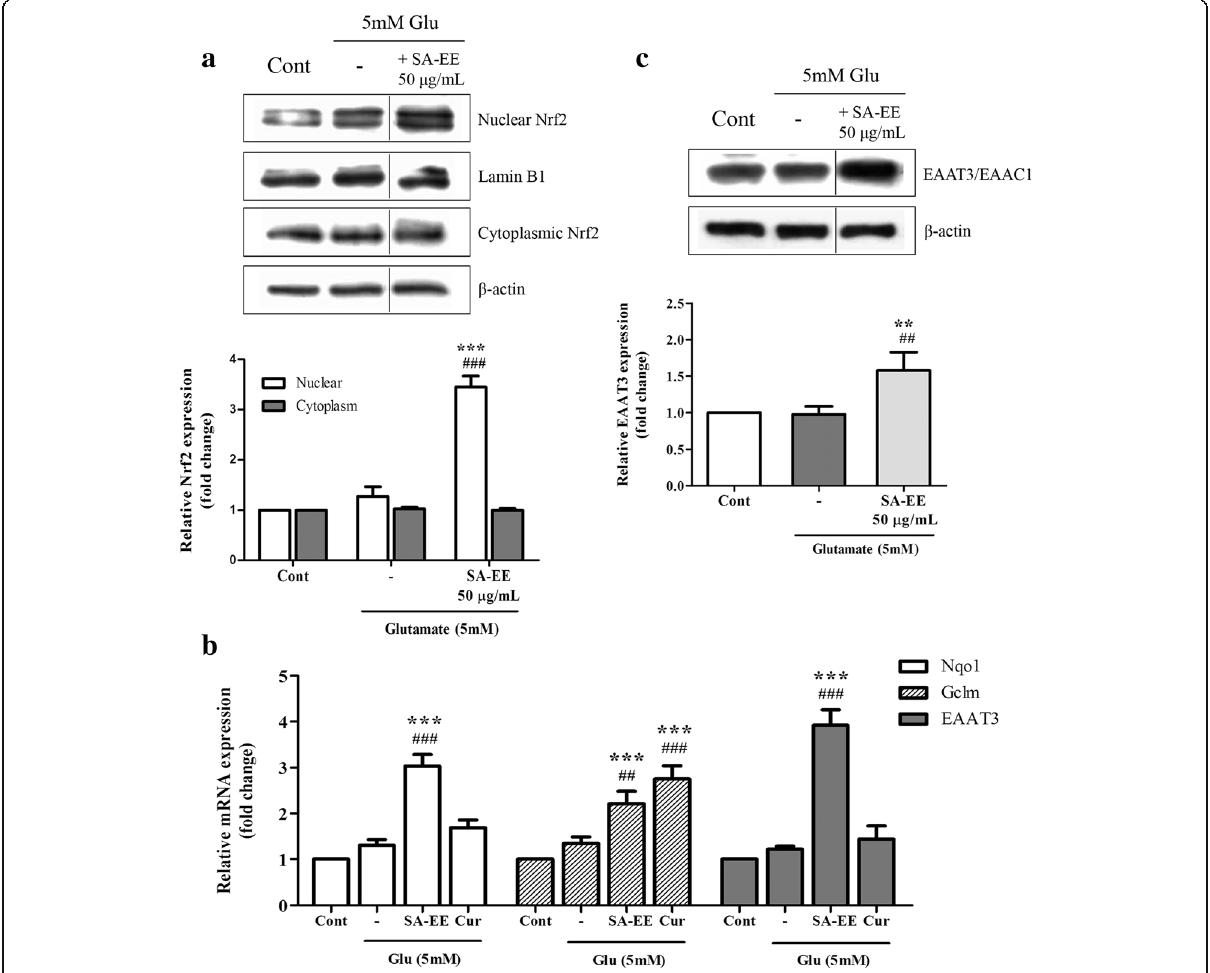
Fig. 3 Effect of SA-EE on Nrf2 pathway activation. HT22 cells were exposed to 5 mM glutamate alone or glutamate in combination with 50 μ g/mL SA-EE for 1 h prior to western blot analysis of nuclear and cytoplasmic Nrf2 levels ( a ). Quantitative real-time RT-PCR analysis of NQO1, GCLM and EAAT3 mRNA expression was performed after treatment of cells with 5 mM glutamate alone or glutamate in combination with 50 μ g/mL SA-EE or 15 μ M curcumin (positive control) for 24 h ( b ). Whole cell lysates were subjected to western blot analysis of EAAT3 level after treating cells with 5 mM glutamate alone or glutamate in combination with 50 μ g/mL SA-EE for 24 h ( c ). Lamin B1 and β -actin served as endogenous loading controls for nuclear extracts and whole cell/cytoplasmic extracts, respectively. β -actin was used as an internal control for RT-PCR assay. All data were normalized to endogenous control levels and are expressed as the mean±SEM of at least three independent experiments. ## P < 0.01, ### P < 0.001 vs. control; **P < 0.01, ***P < 0.001 vs. glutamate